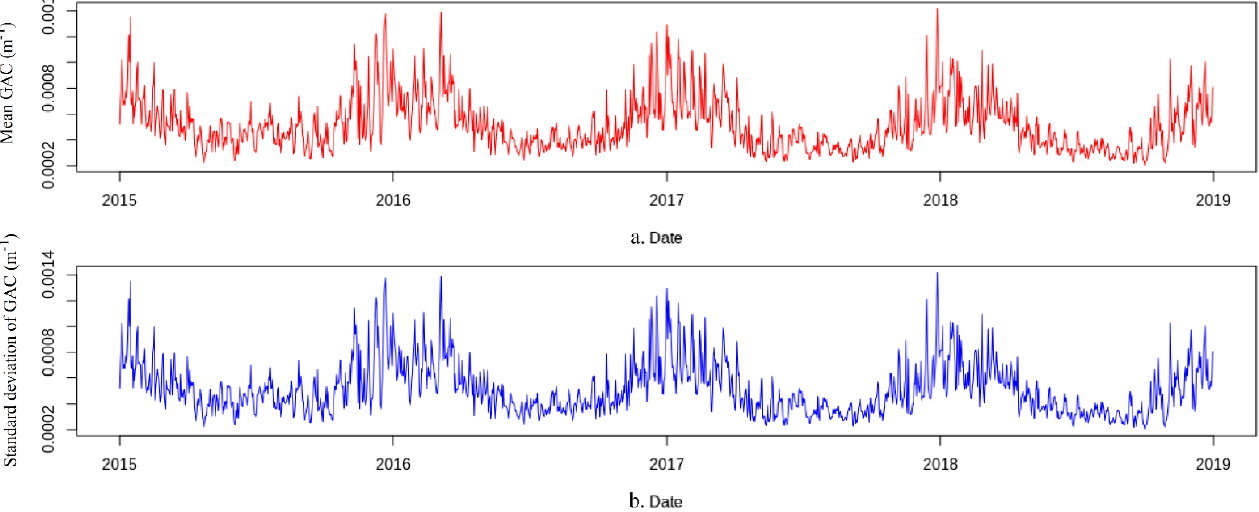
Figure 8. Time series of the mean (a) and standard deviation (b) of ground aerosol coefficient (GAC) in mainland China for 2015–2018.